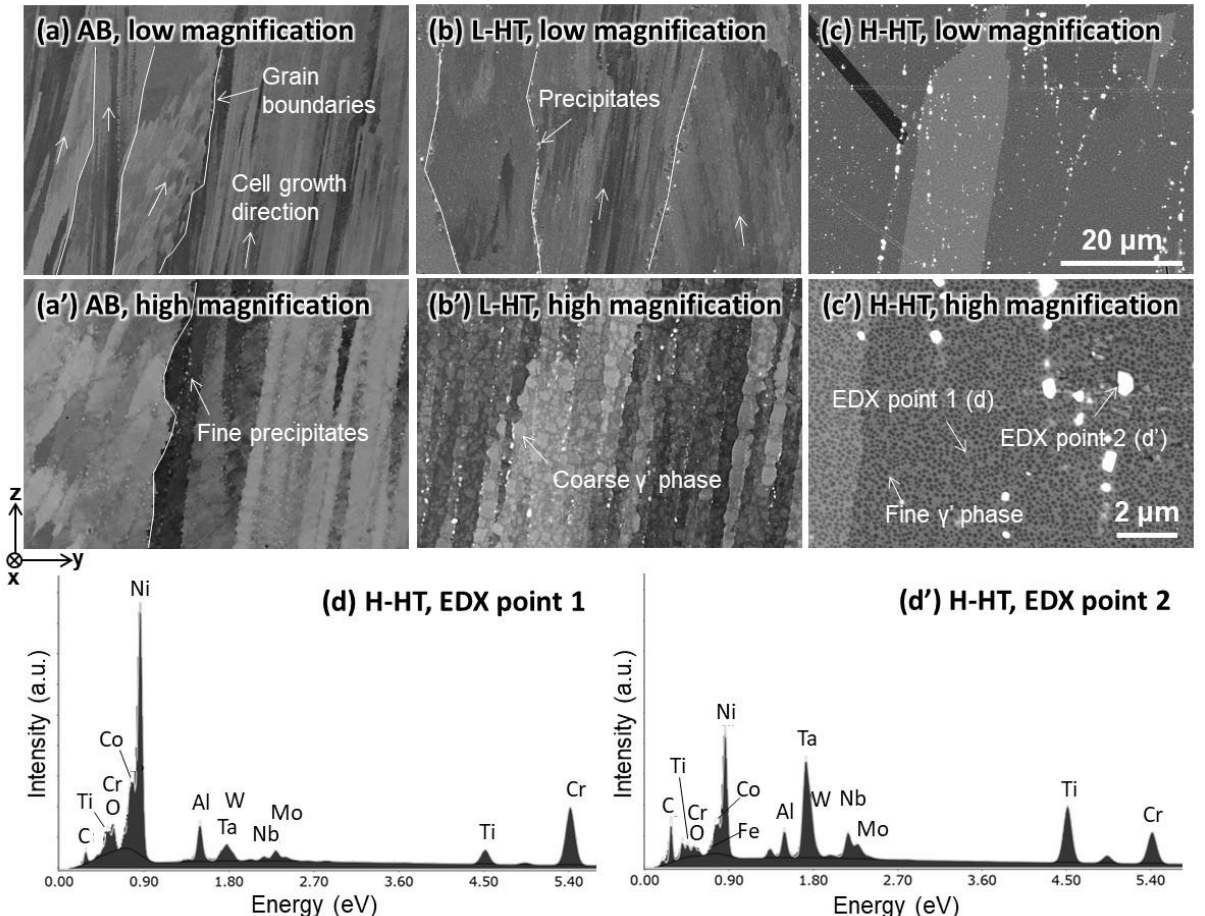
Figure 4. SEM images of ( a,a’ ) AB, ( b,b’ ) L-HT-ed, and ( c,c’ ) H-HT-ed materials with two magnifications. EDX spectra obtained from H-HT-ed material at ( d ) point 1 and ( d’ ) point 2.